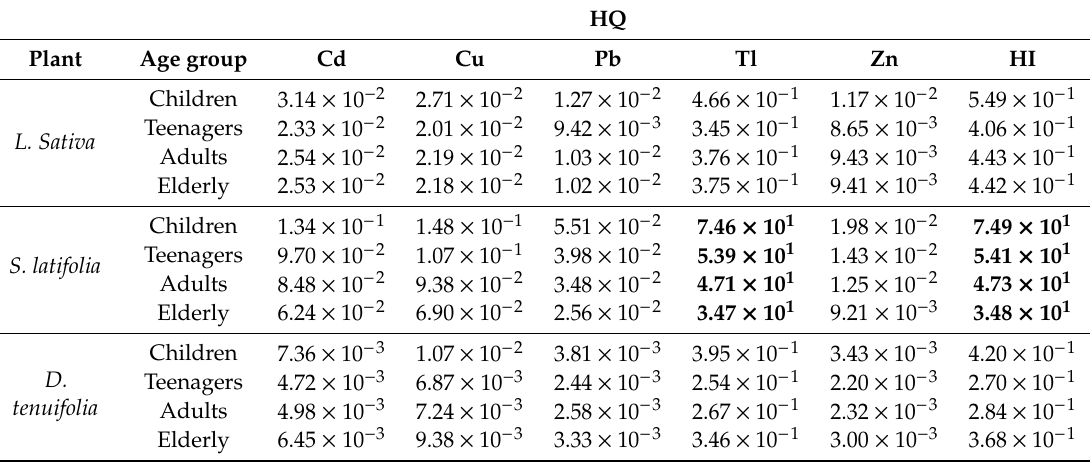
Table 7. Hazard quotients (HQ) and hazard indexes (HI) through dietary intake of L. sativa, D. tenuifolia and S. latifolia by